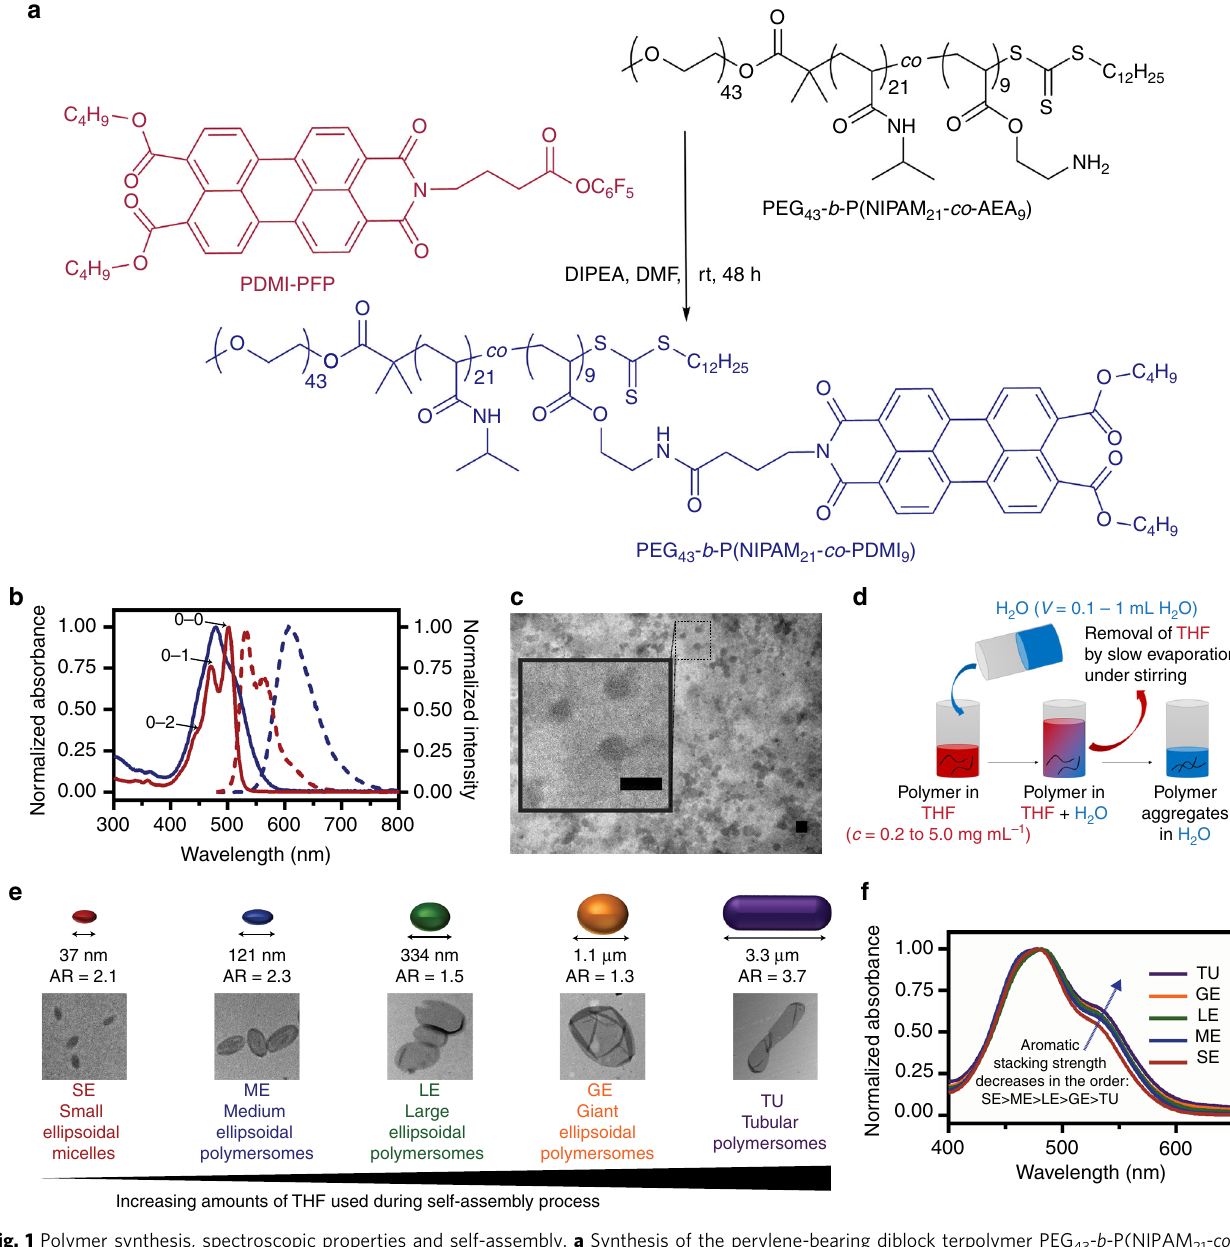
Fig. 1 Polymer synthesis, spectroscopic properties and self-assembly. a Synthesis of the perylene-bearing diblock terpolymer PEG 43 - b -P(NIPAM 21 - co - PDMI 9 ). b Normalized absorption (solid lines) and fl uorescence spectra (dashed lines) of the amine-reactive perylene derivative PDMI-PFP (red) and PEG 43 - b -P(NIPAM 21 - co -PDMI 9 ) (blue) in THF. c TEM image of spherical aggregates formed by PEG 43 - b -P(NIPAM 21 - co -PDMI 9 ) in a dilute THF solution (0.1 mg mL − 1 ). Scale bar, 100 nm. d Schematic representation depicting the solvent-switch method used to induce self-assembly of PEG 43 - b -P(NIPAM 21 - co -PDMI 9 ). e Schematic representations, average major axis lengths, aspect ratios, and TEM images of resulting self-assembled structures formed at different THF content. f Normalized absorption spectra of all fi ve polymersomes in